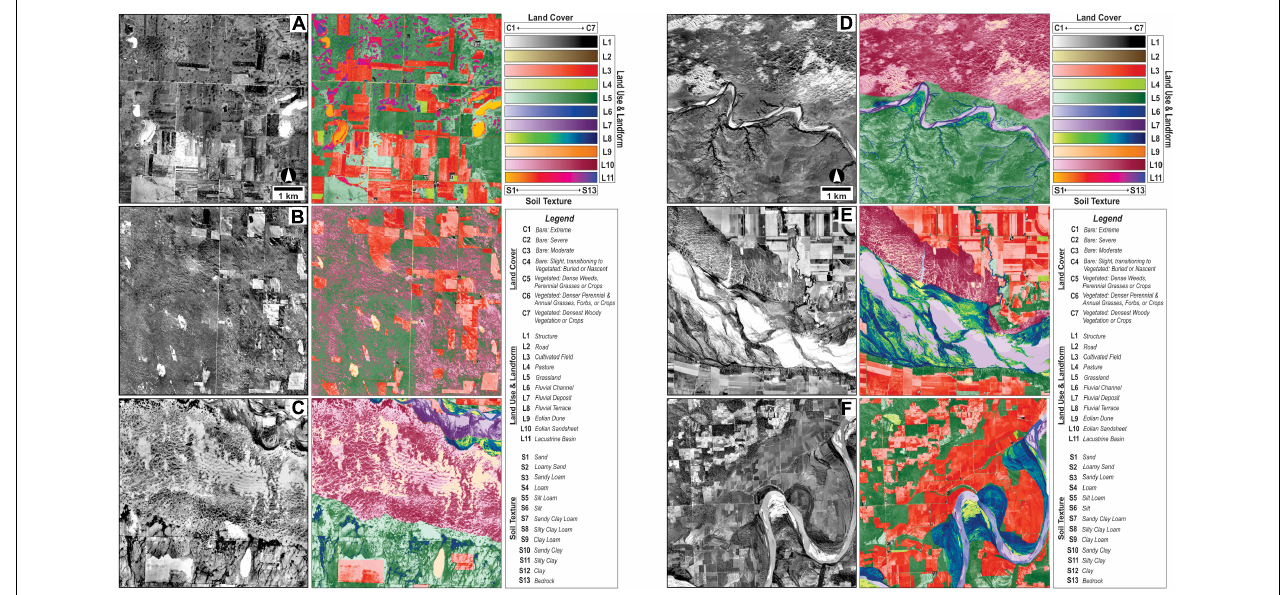
Refer to Table 4 for surface type code description. The italicized values reference the previous table for description of the notations for surface type.